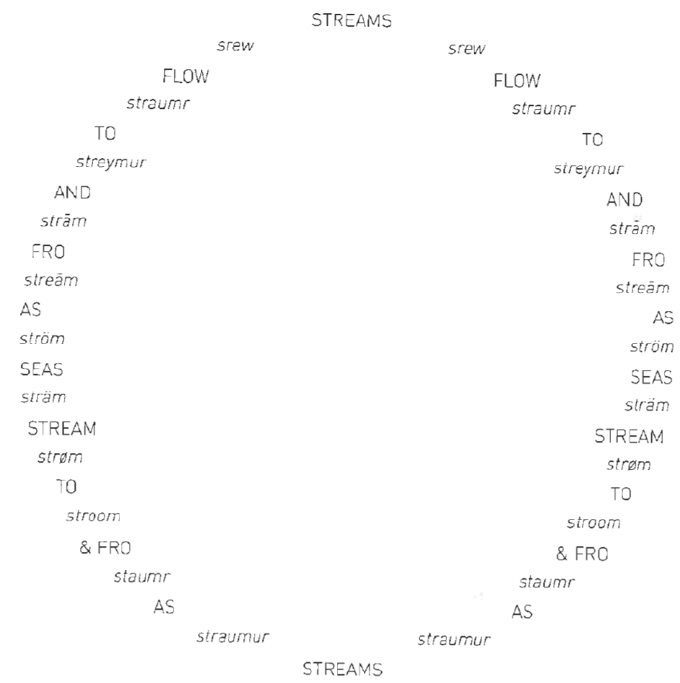
Figure 1. ‘Streams’, (Finlay et al. 2015, p. 48).